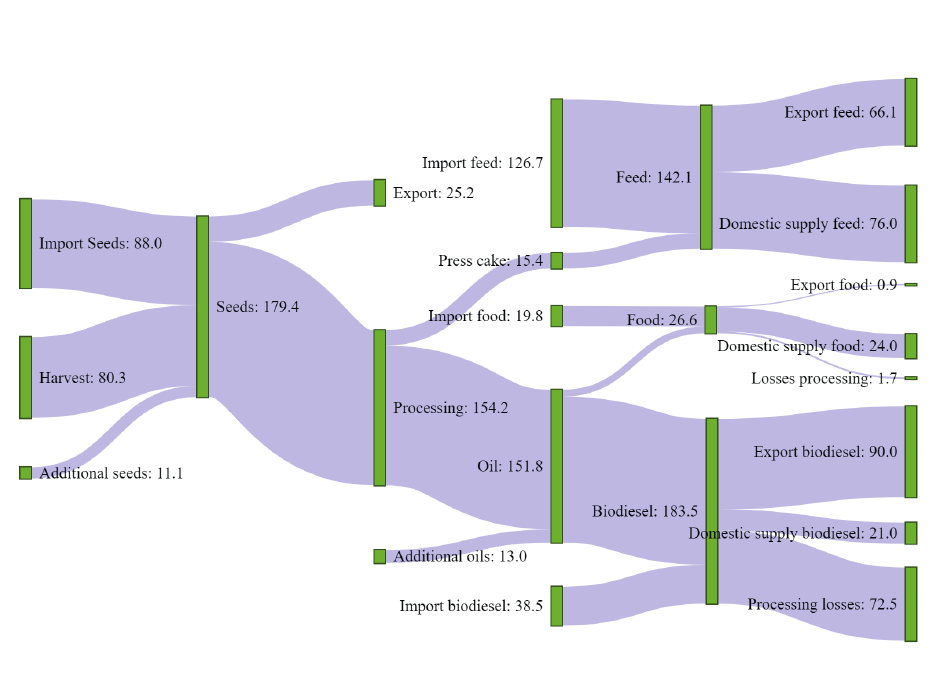
Fig. 5. Sankey diagram for bioresource flows of base scenario in 2030 for vegetable oils, thousand